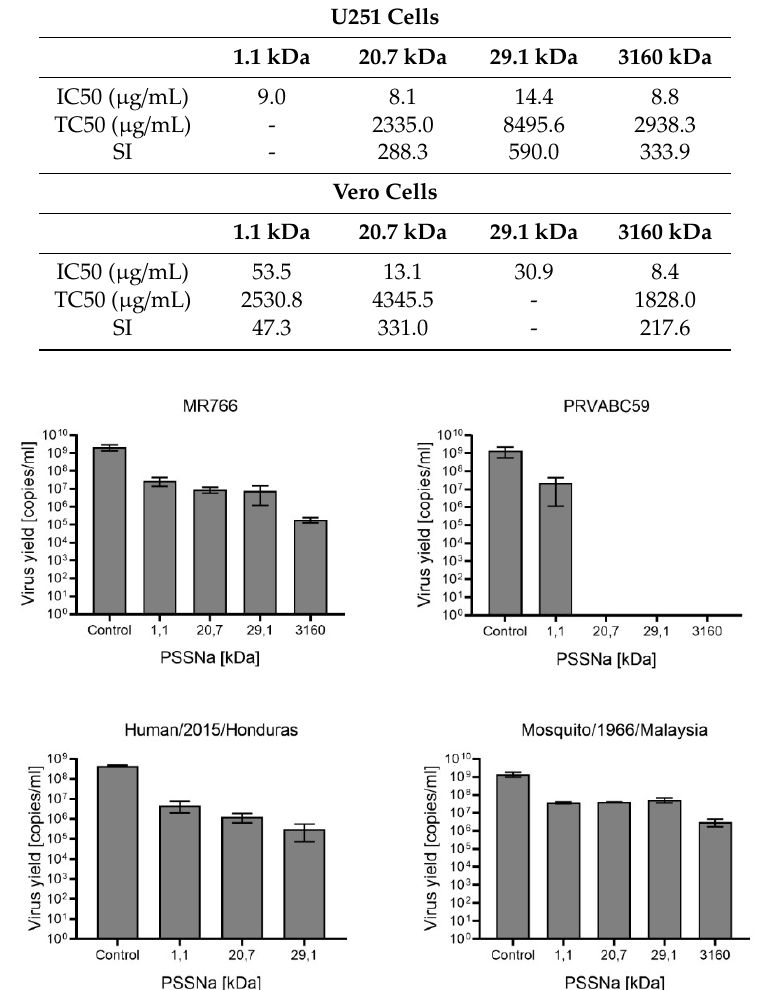
Figure 4. Inhibition of di ff erent strains of ZIKV replication cycle by PSSNa. U251 cells were infected with the virus in the presence of di ff erent polymers for four days. Inhibition of the infection was evaluated using RT-qPCR. Data are shown as virus yield (copies of viral genome per milliliter). The results are presented as average values of at least three